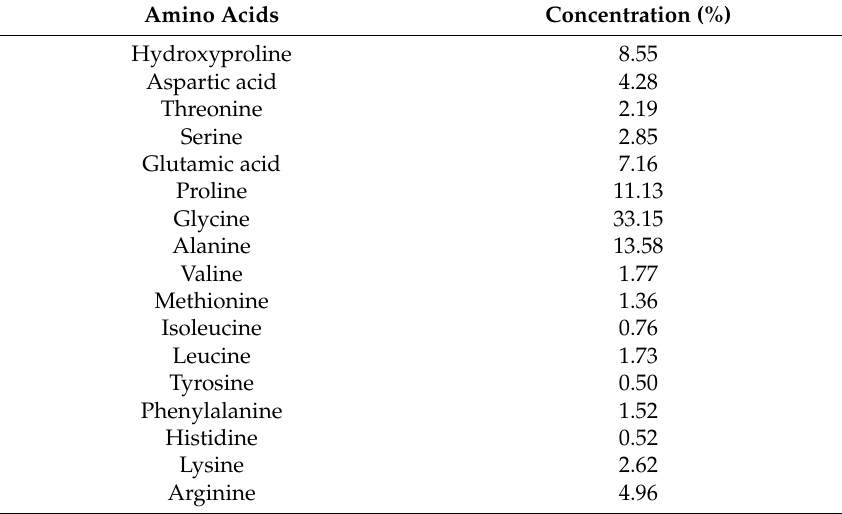
Table 1. Amino acid content of fish gelatin expressed as number of residues per 100